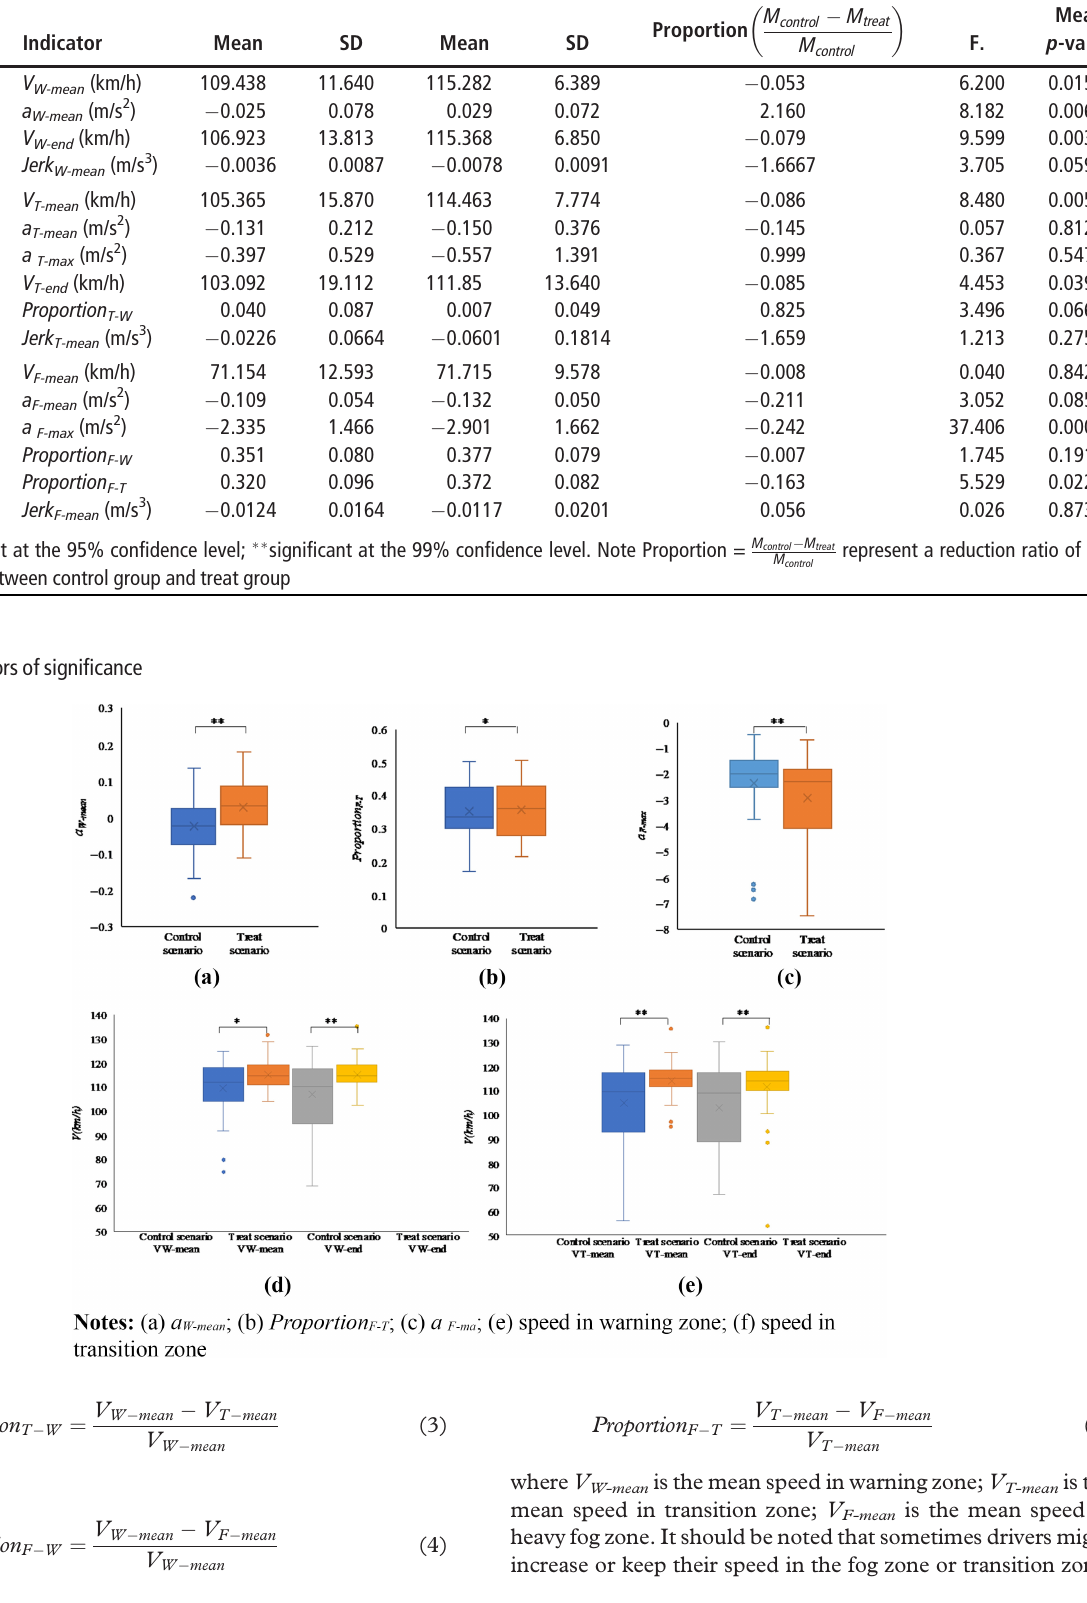
Table 4 Descriptive statistics of dependent variable